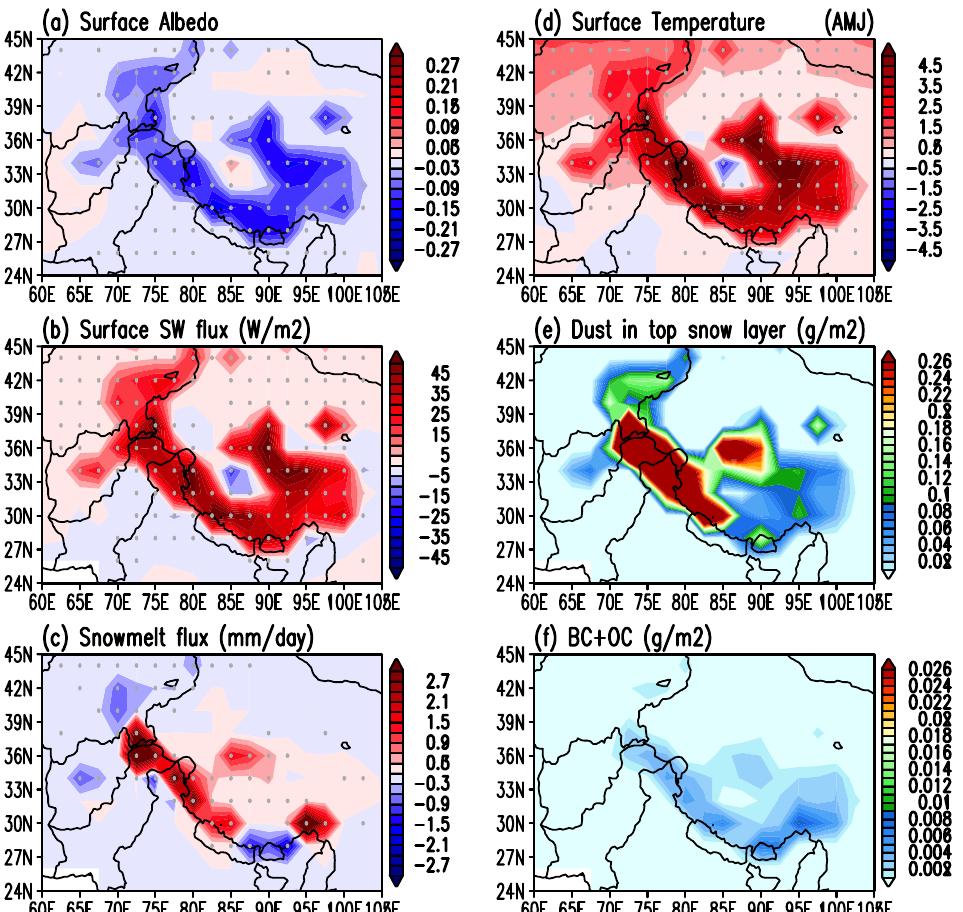
Figure 2. Anomalies induced by snow-darkening effects over the Himalayas–Tibetan Plateau region, for ( a ) surface albedo, ( b ) surface shortwave (SW) fluxes, ( c ) snowmelt, ( d ) surface temperature, ( e ) dust in snow, and ( f ) carbonaceous aerosols (organic carbon (OC) + black carbon (BC)) in snow. Grey dots indicate 95% statistical confidence. Dust and carbonaceous aerosols in snow are set to zero in the second set of experiments (NSDE).